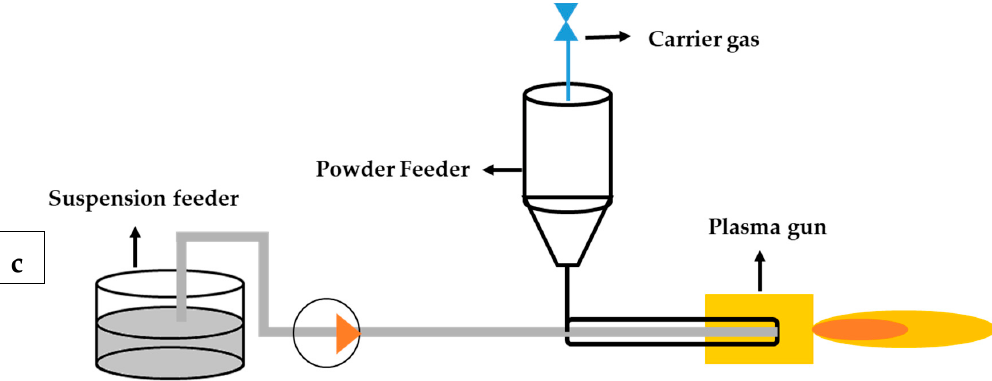
Figure 1. Schematic representation of the axial plasma spraying process of ( a ) Ap, ( b ) As and AsYs ( c ) ApYs coatings.